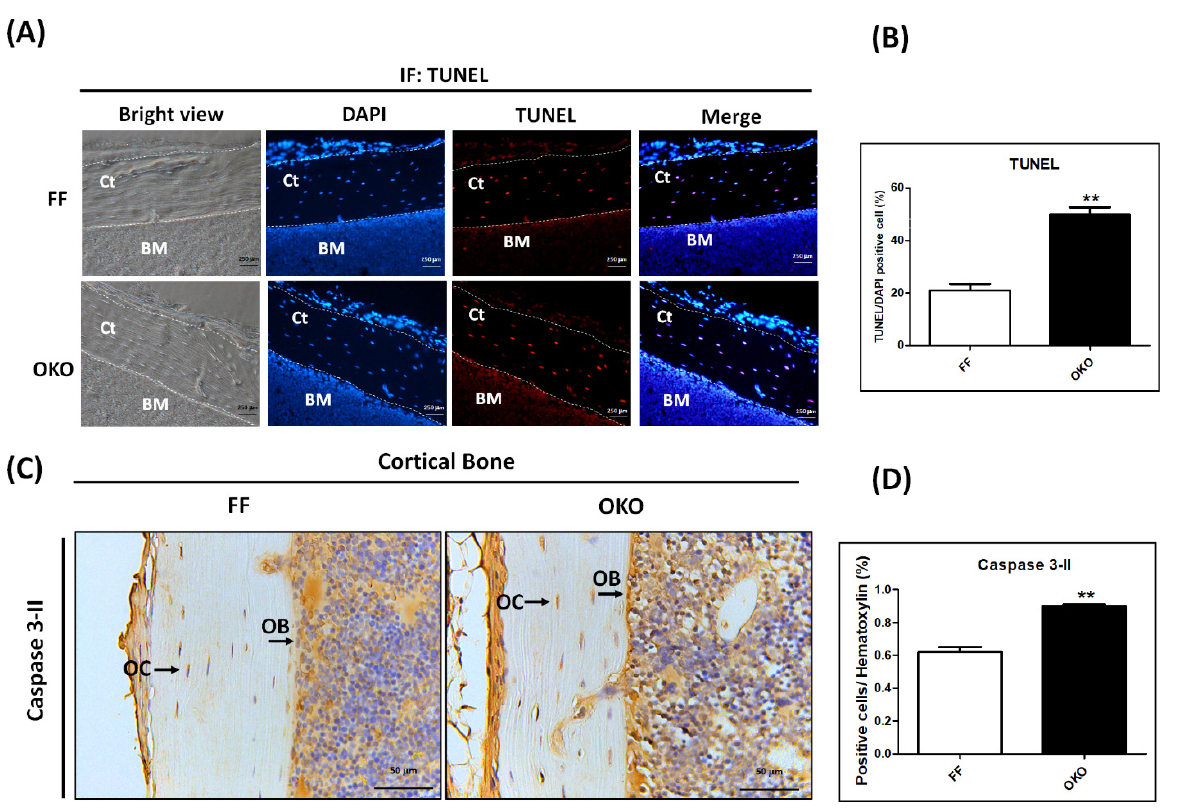
Figure 5. Knockout of DDR1 in OKO mice significantly increased apoptotic osteoblasts/osteocytes. ( A ) TUNEL staining in femoral cortical bone of FF and OKO mice. The magnification is 100 × , and the scale bar is 250 µ m. Red: TUNEL-positive cells; blue: DAPI-stained cells. ( B ) Quantification of TUNEL-positive cells in the area beneath the cortical bone. ( C ) The representative micrographs of IHC of activated caspase-3 (caspase 3-II). ( D ) Quantitative analysis of the IHC staining of activated caspase-3. The positive immunolocalizations are stained dark brown. A black arrow indicates positive cells (OB + OC); OB: osteoblasts, OC: osteocytes. Magnifications of 400 × are shown, with scale bars of 50 µ m. Each bar represents the mean ± SE of six samples in each group (** p < 0.01 versus FF mice).